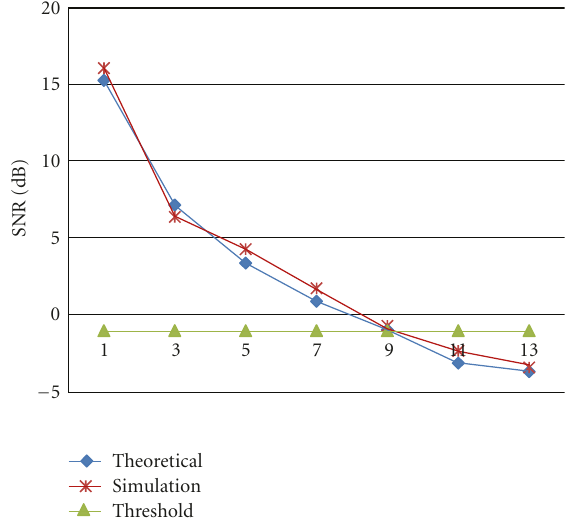
Figure 3: SNR performance versus distance